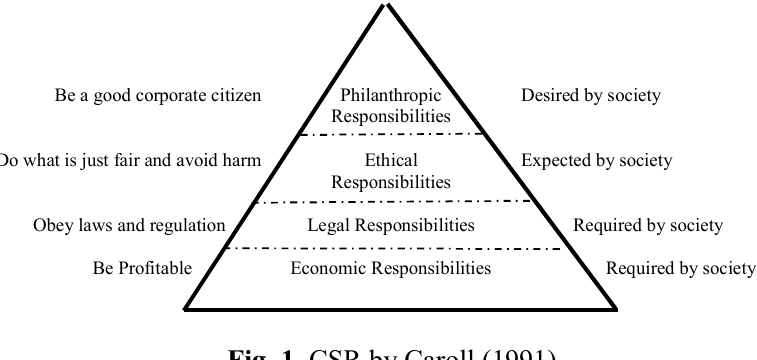
Fig. 1. CSR by Caroll